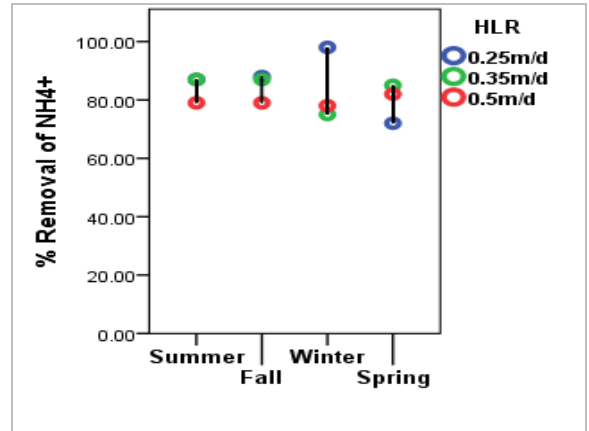
Figure 9. Performance of